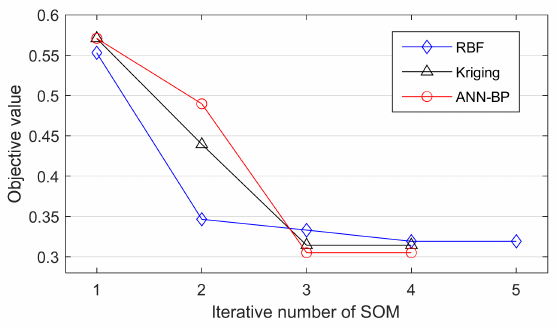
Figure 9. Convergence processes of sequential optimization method (SOM) with three surrogate models (RBF, Kriging, and ANN) for the optimization of SMES. Table 4. Optimization results of SMES with different models.